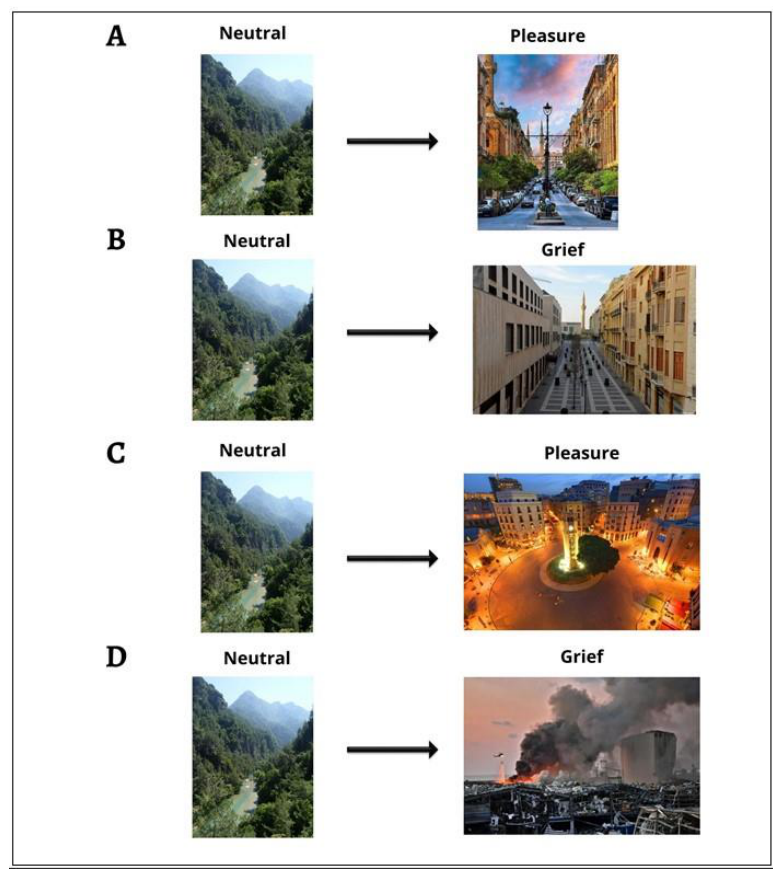
Figure 4. Pictorial stimulation was carried out with two alterative sets in the experiment with ( A , C ) for pleasure draggle and ( B , D ) for grief draggle. for pleasure draggle and ( B , D ) for grief